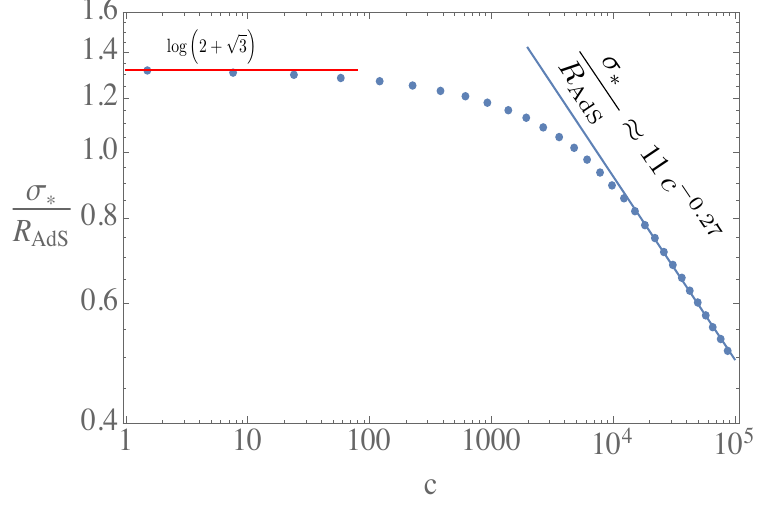
Figure 5 . In this plot we used the (cid:12)ts of (cid:12)gure 4 to extract an approximate asymptotic ratio a n +1 which was then used to identify (cid:27) each value of c . For very small values of c we (cid:12)nd (cid:27) smoothly match the large h results of section 3.3, as indicated by the red line. At large c we enter the (cid:13)at space regime of small (cid:27)